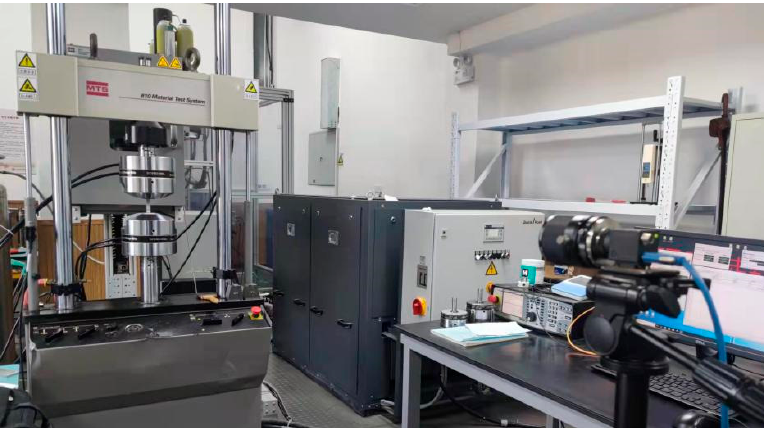
Figure 10. Uniaxial tensile test of specimens.